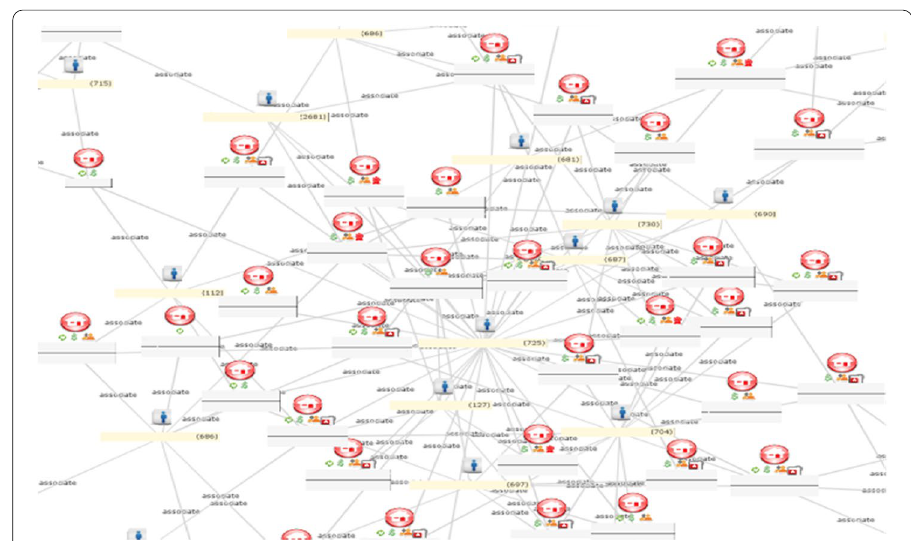
Fig. 1 A network of individuals associated by personal